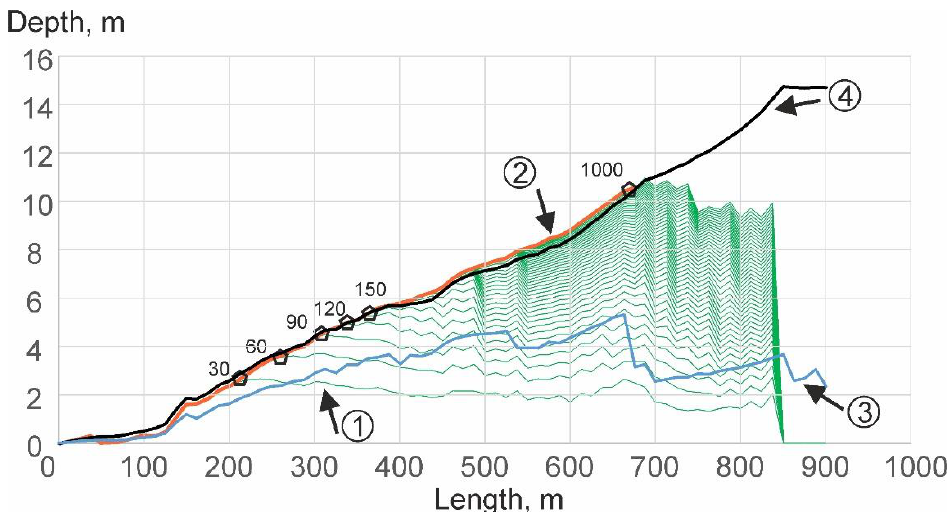
Figure 4. Histogram of daily surface runoff at the gully P-1 catchment.